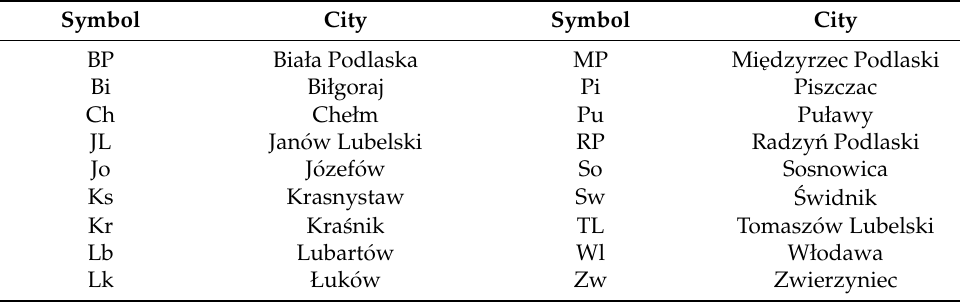
Table 1. Symbols of places on the map and